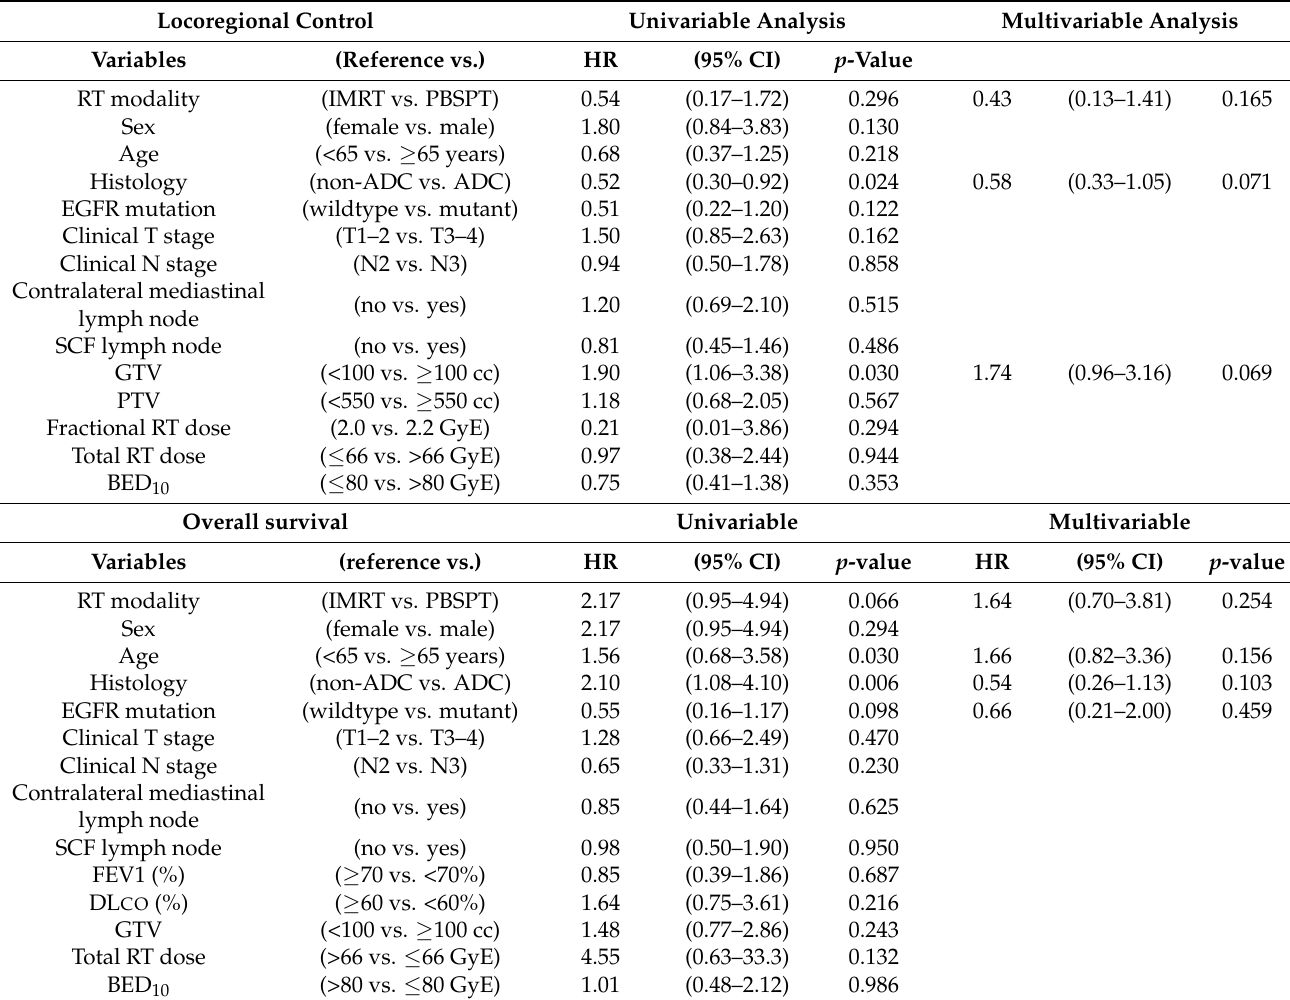
Figure 2. Clinical outcomes after IMRT and PBSPT: LRC ( A ) and OS ( B ). Abbreviations: IMRT, intensity-modulated radiation therapy; PBSPT, pencil beam scanning proton therapy; LRC, locoregional control; OS, overall survival. Table 2. Prognostic factors for locoregional control and overall survival.